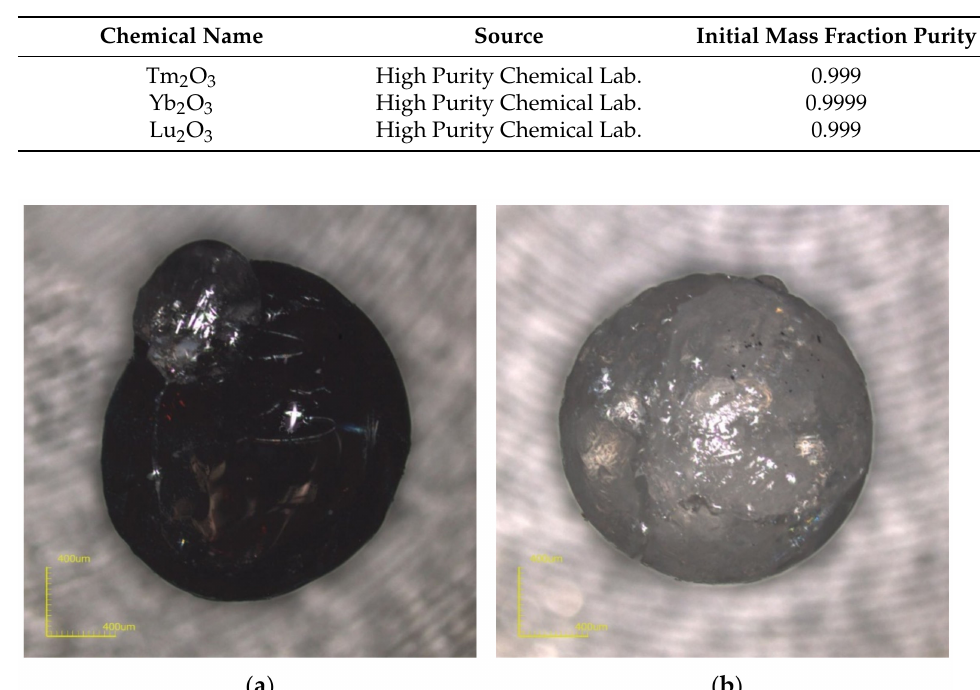
Table 1. Source and mass fraction purity of samples used in this study.